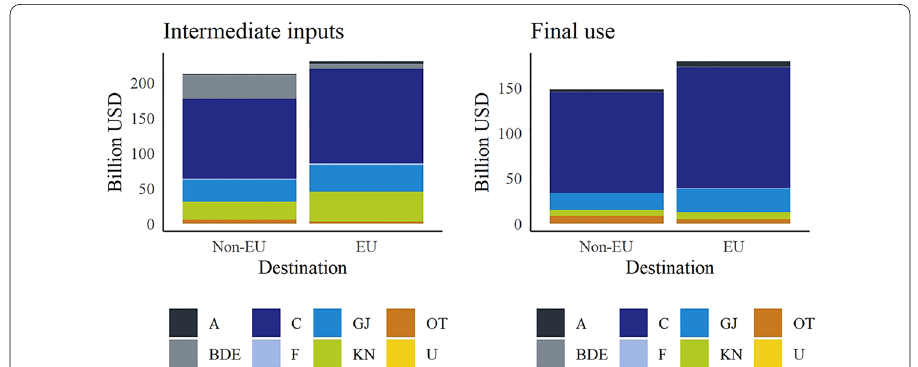
Fig. 1 UK imports from EU and non‑EU countries in 2014. Source: World Input–Output Database, data for 2014, and own calculations. NACE sectors are defined in Tables 5 and 6 in the